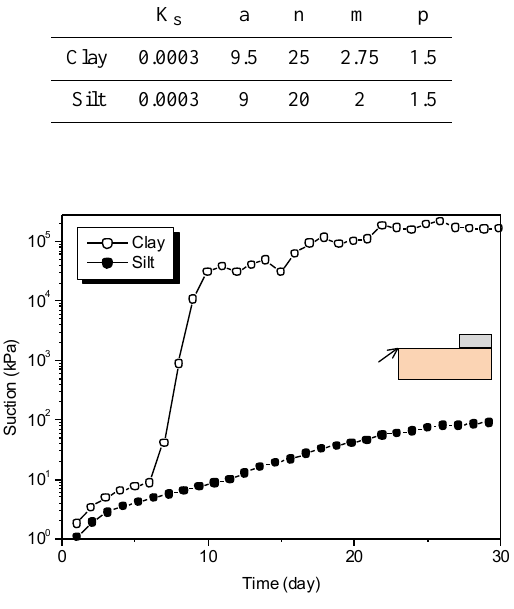
Figure 13a. Influnce the soil type on the variation of the suction in point A Fig. 13a. Influnce of the soil type on the variation of the suction in point